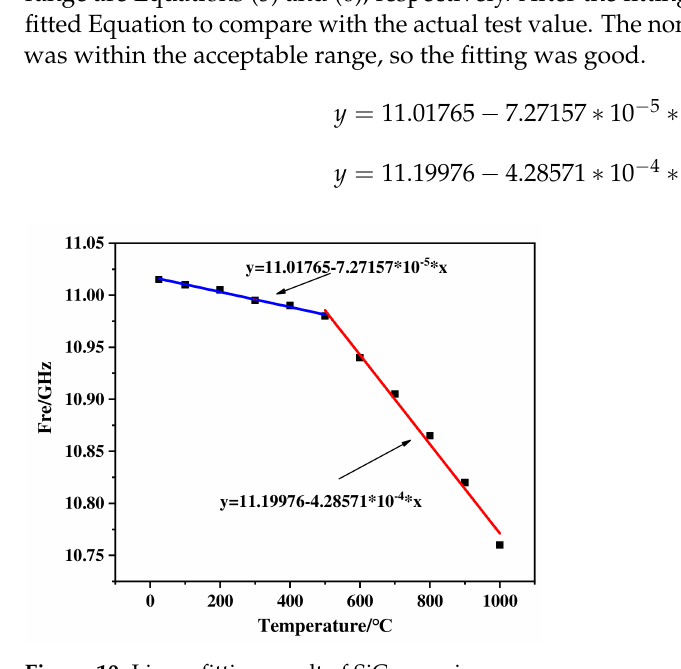
Figure 10. Linear fitting result of SiC ceramic